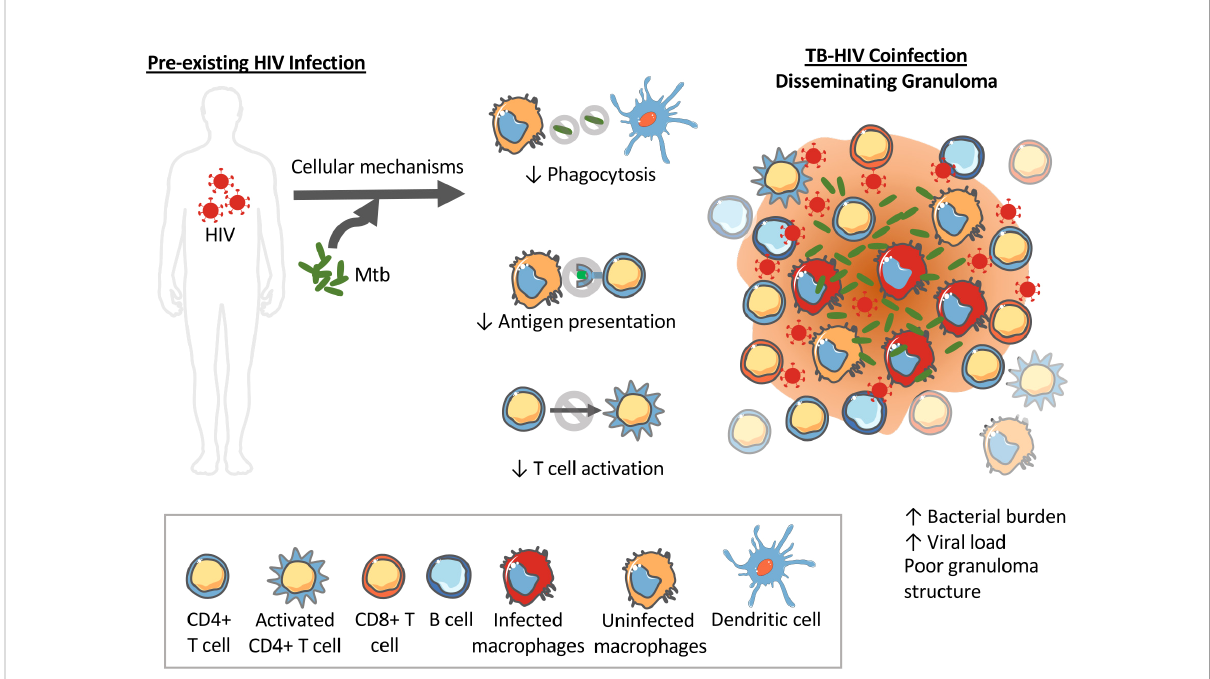
FIGURE 2 Pre-existing HIV impacts innate immune functions that can impact Mtb granuloma development and progression. HIV can alter the phagocytosis abilities of dendritic cells and macrophages limiting their ability to kill intracellular Mtb . HIV also interferes with antigen processing and presentation required to activate T cells. The result is disorganized granulomas with high bacterial load, high viral load, and high dissemination rates.